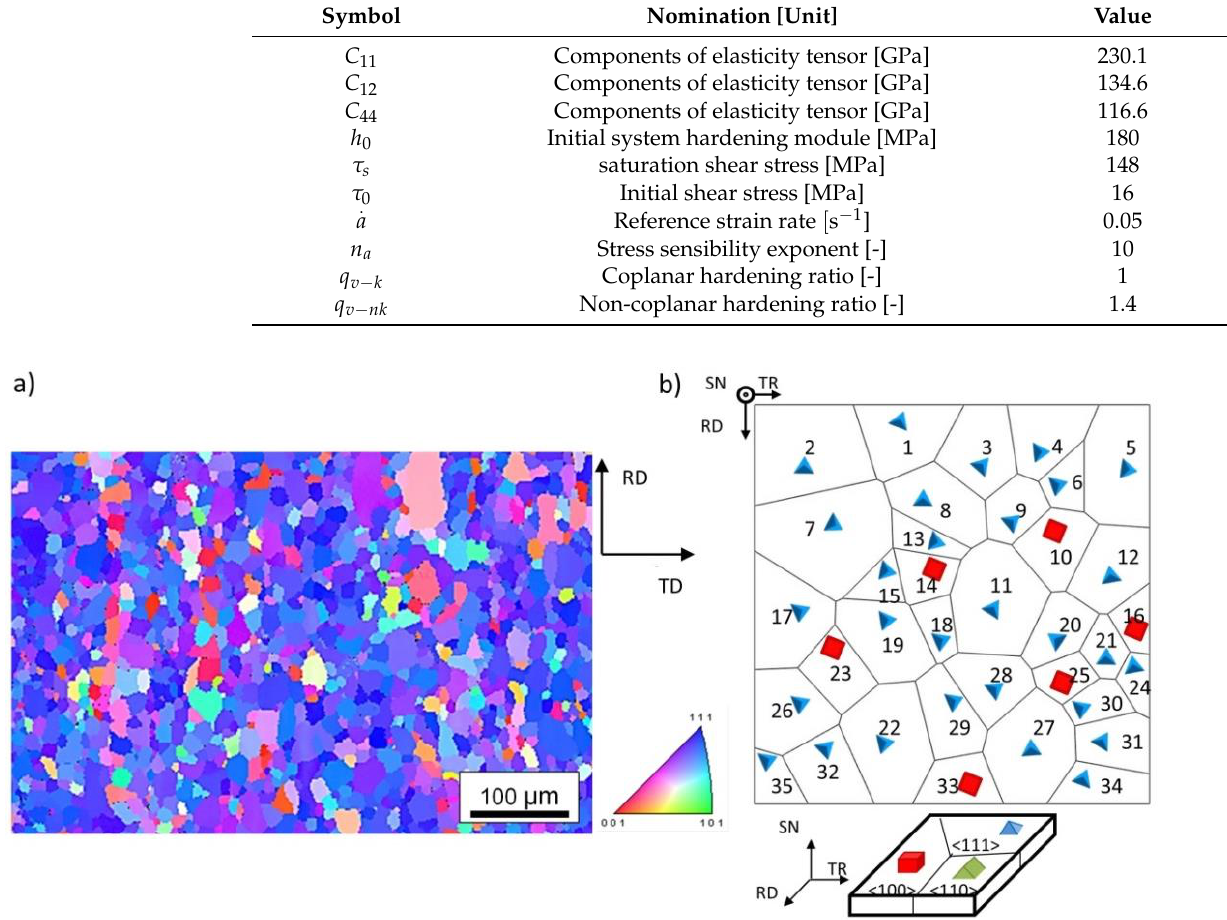
Table 1. Parameters of material models according to Huang et al. [29] and Raabe [30].